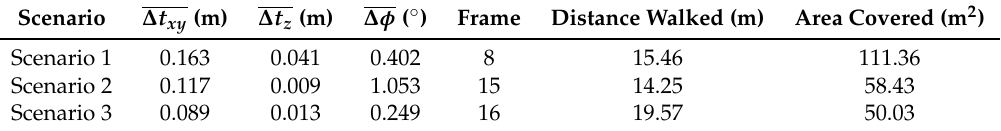
Table 1. Results of the localization accuracy and reliability for each scenario: ∆ t and ∆ φ are the average localization accuracy for correctly localized poses. ∆ t xy is the distance error over the template-matched xy plane. ∆ t z is the distance error of the ground-plane estimation along the z -axis. Frame is the point in time when the scenario was first localized correctly, with the according distance walked and area covered at that